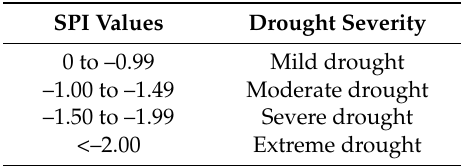
Table 2. Drought intensities according to the size of standard deviation